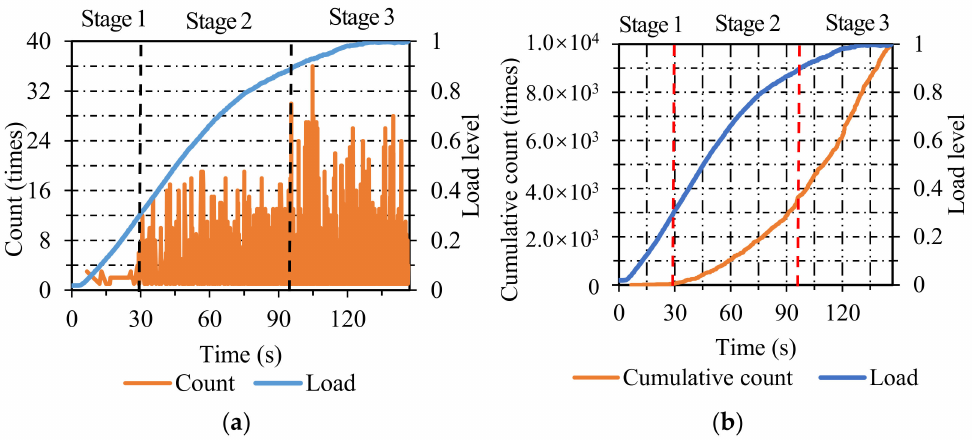
Figure 7. The count and cumulative count distribution of SMA: ( a ) count; ( b ) cumulative